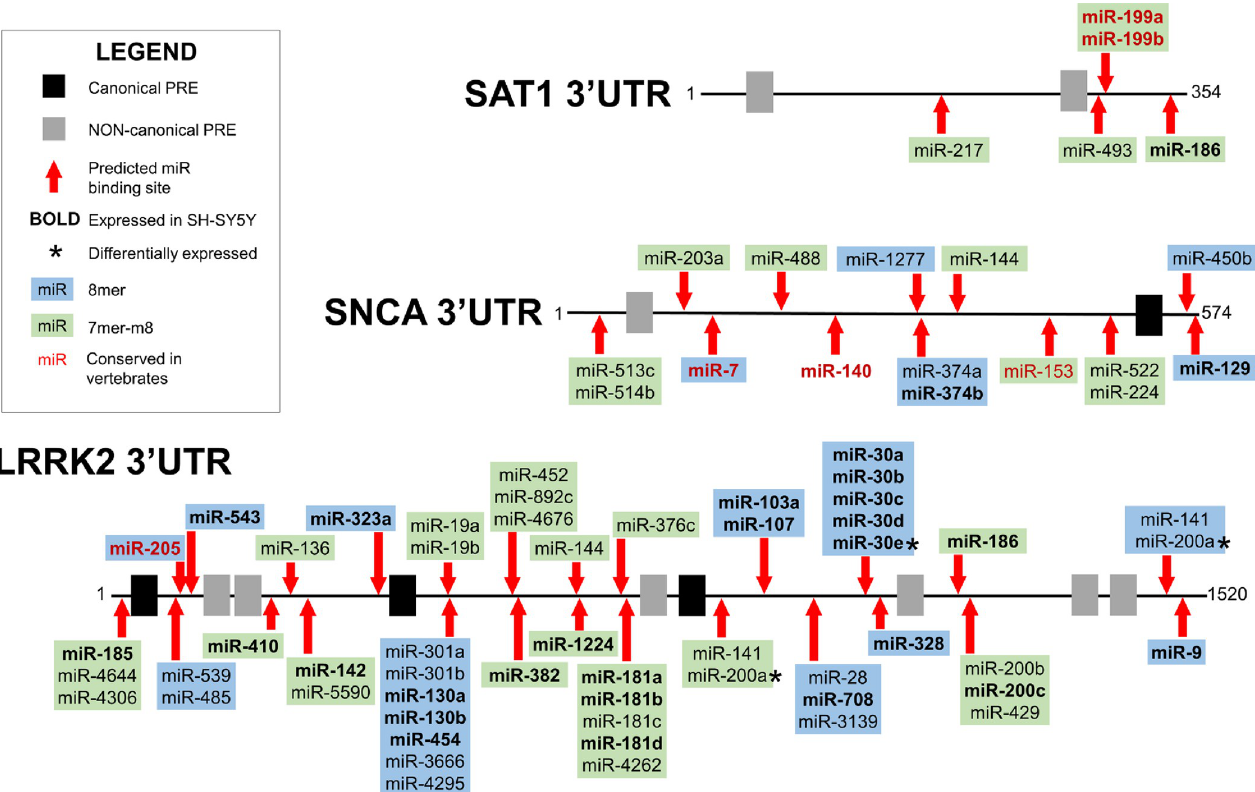
Fig 1. PRE and microRNA binding sites in the 3’UTRs of LRRK2 , SNCA , and SAT1 . The black lines are a linear representation of the 3’UTRs of SAT1 , SNCA , and LRRK2 transcripts. The number 1 indicates the nt immediately following the stop codon (5’ end of the 3’UTR). 3’UTR lengths for LRRK2 and SAT1 were based on transcript data from NCBI and 3’UTR length for SNCA was based on NCBI data as well as empirical data from expressed sequence tags [22]. Motifs with the sequence UGUA(A/U/C)AUA are considered canonical PREs and their locations on the 3’UTRs are represented by black boxes. Motifs that do not match the canonical sequence but contain a UGUA with downstream AU-rich region are considered non-canonical and are represented by gray boxes. The relative locations of predicted miR-binding sites are represented by red arrows. MiRs confirmed to be expressed in SH-SY5Y cells using sRNA-seq are bolded. MiRs with an asterisk ( � ) were determined to be differentially expressed based on DEseq2 analysis. MiR family conservation is based on TargetScanHuman 8.0 categorizations [71]. Broadly conserved miR families, those conserved among vertebrates, are represented by red text. All other levels of conservation are represented by black text. 8mer sites are highlighted in blue and 7mer-m8 sites are highlighted in green. 3’UTRs and predicted sites are not drawn to